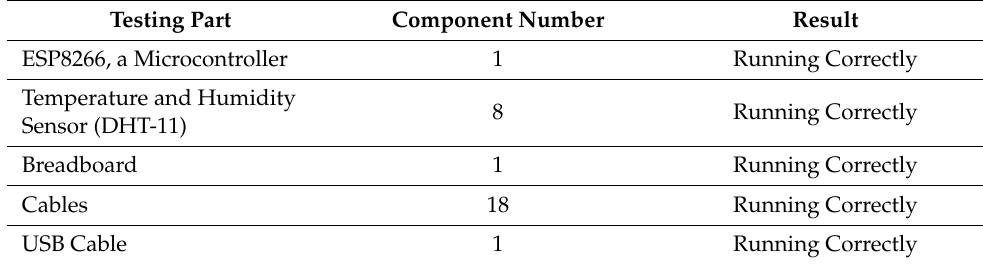
Table 4. The testing of each